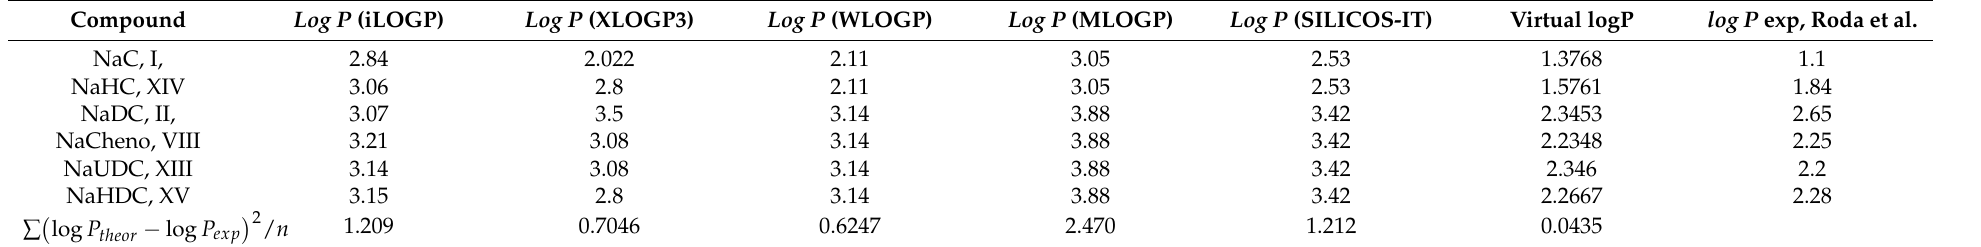
Table 2. log P values calculated by the indicated methods for natural unconjugated bile salts, for which experimental values have been measured (Roda et al. [9]).